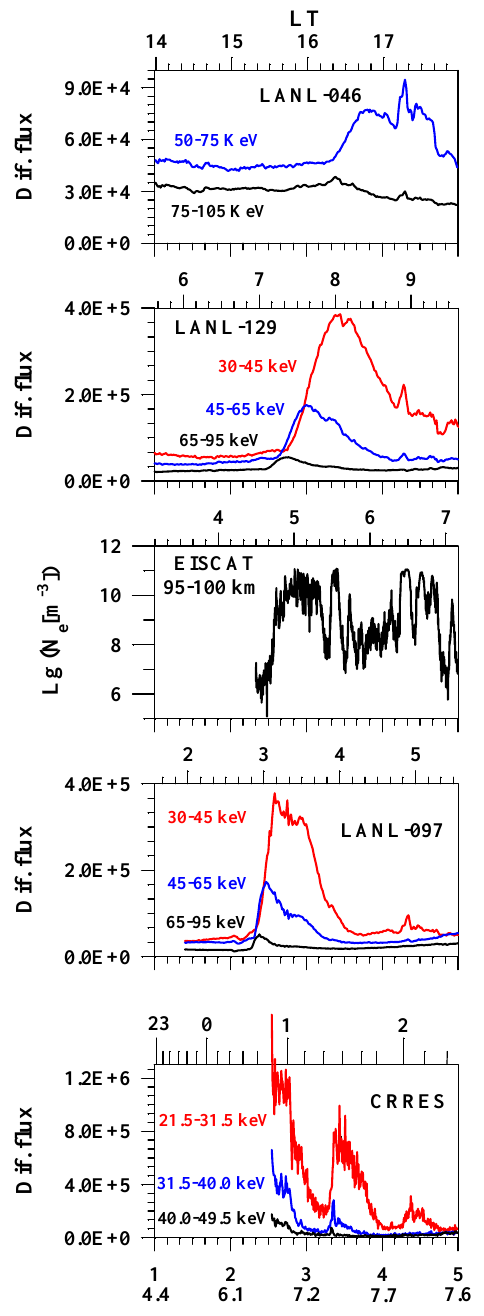
Fig. 1. Omnidirectional differential fluxes of electrons (in cm − 2 s − 1 sr − 1 keV − 1 ) in several energy channels, obtained on board the CRRES satellite and three geostationary LANL satellites spaced in longitude, and also the ionospheric electron density within the altitude range from 95 to 100km, observed by the EISCAT UHF radar, versus the universal time UT (bottom horizontal axis) and lo- cal time LT (upper horizontal axis). For the CRRES satellite its L-shell is also